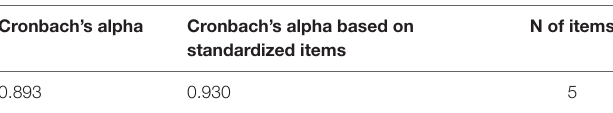
TABLE 2 | Reliability statistics.